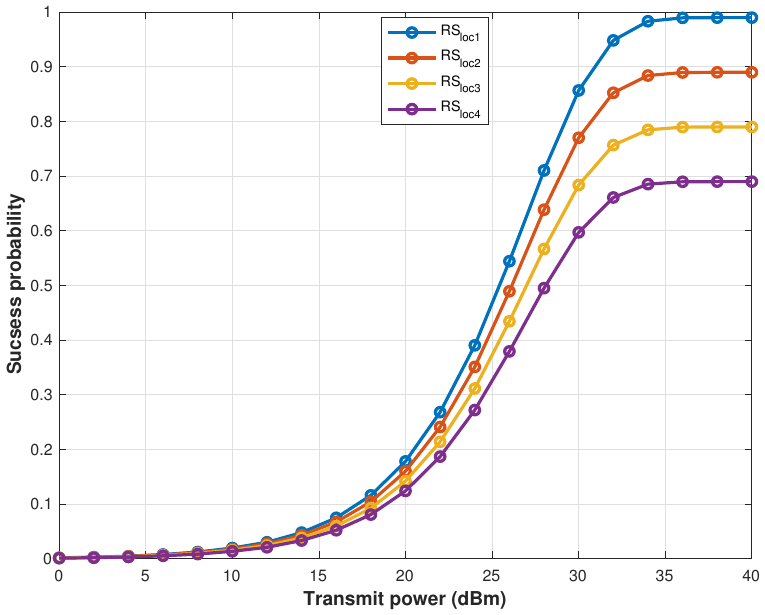
Figure 5. The success probability when RS transmits its signal by different power values at different locations.